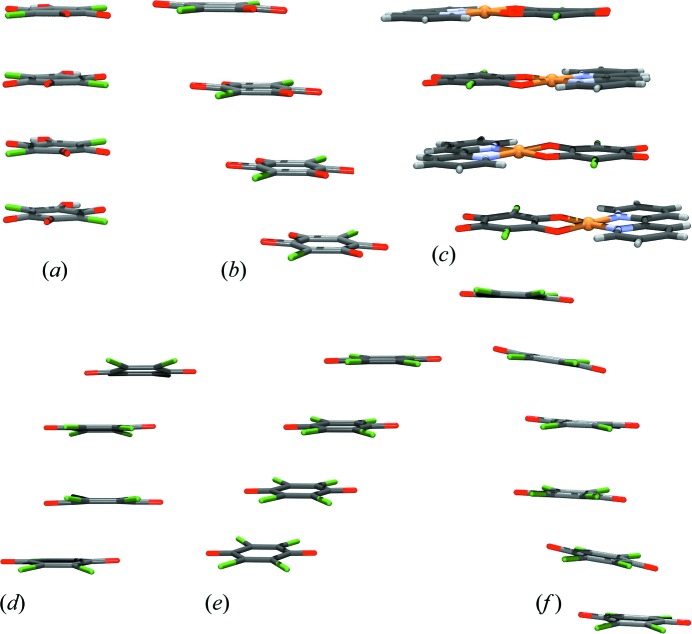
Stacks of non-aromatic rings. (a) Hydrogen chloranilate anions in KHCA·2H2O (Molčanov et al., 2009b
 ▸), (b) chloranilate dianions in Na2CA·2H2O (Molčanov et al., 2009a
 ▸), (c) [Cu(CA)(2,2′-bpy)] (Molčanov et al., 2013a
 ▸), (d) pancake-bonded dimers of tetra­chloro­semi­quinone radical anions in triclinic N-MePy·Cl4Q (Molčanov et al., 2016 ▸), (e) equidistant tetra­chloro­semi­quinone radical anions in orthorhombic N-MePy·Cl4Q (Molčanov et al., 2016 ▸) and (f) triplets of partially charged tetra­chloro­semi­quinone radicals in (4-damp)2(Cl4Q)3 (Molčanov et al., 2018a
 ▸). Stacks (a), (b) and (c) comprise closed-shell rings, while (d), (e) and (f) are radicals.